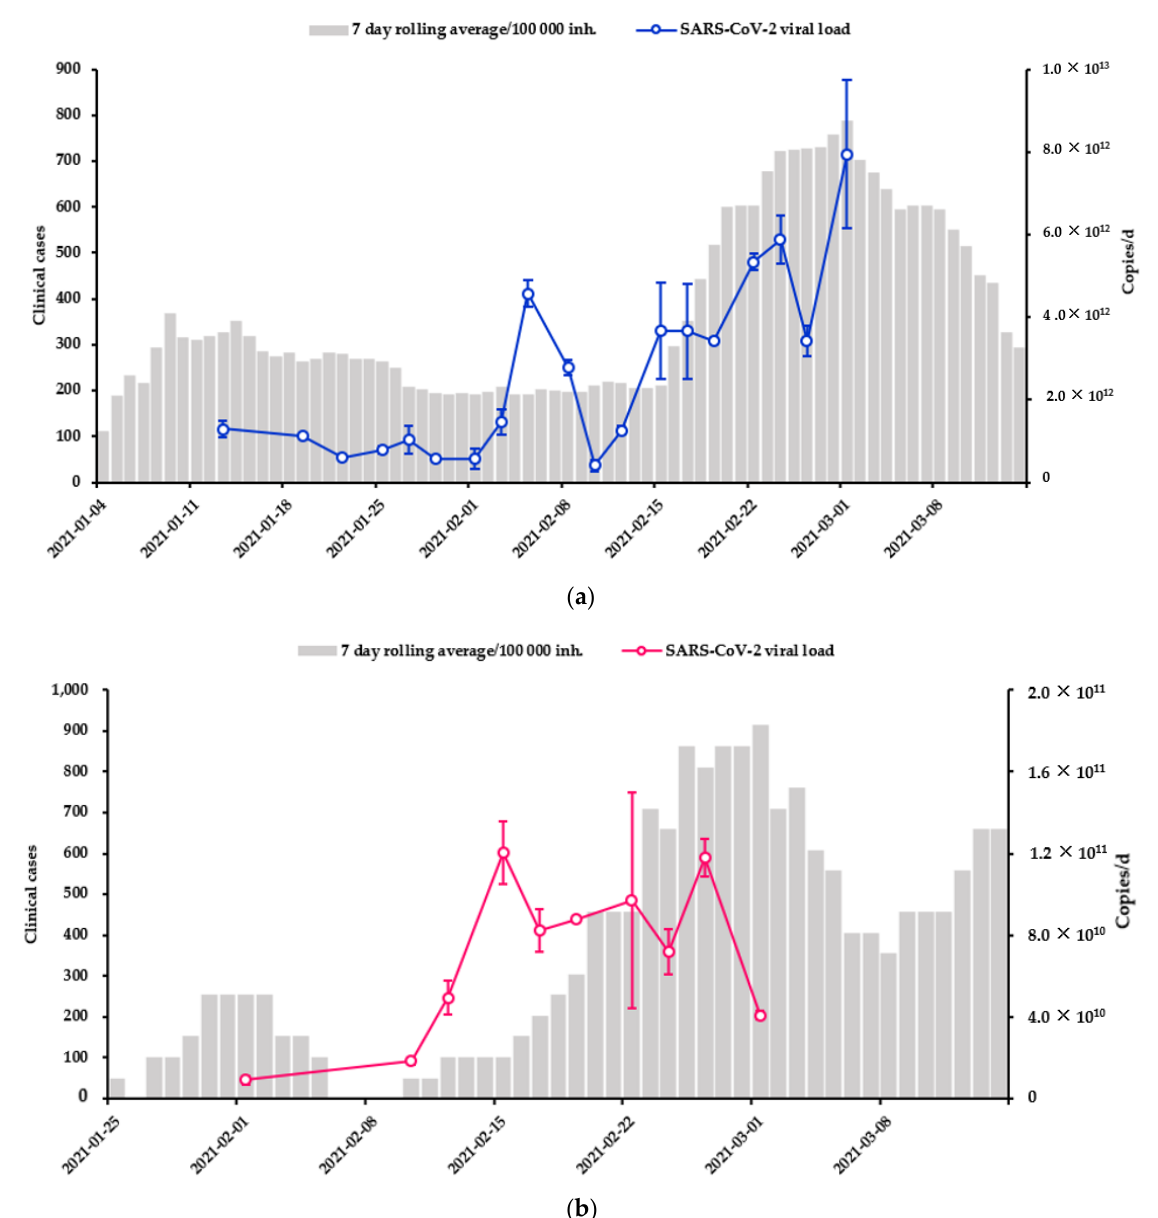
Figure 3. Longitudinal data of flow-normalized SARS-CoV-2 viral loads together with clinical cases, presented as 7 day rolling average per 100,000 inh. (based on day of testing) at: ( a ) UDD WWTP and ( b ) RAN WWTP (note: the date indicates the first Monday of each week and error bars depict the standard deviation of sampling date replicates).